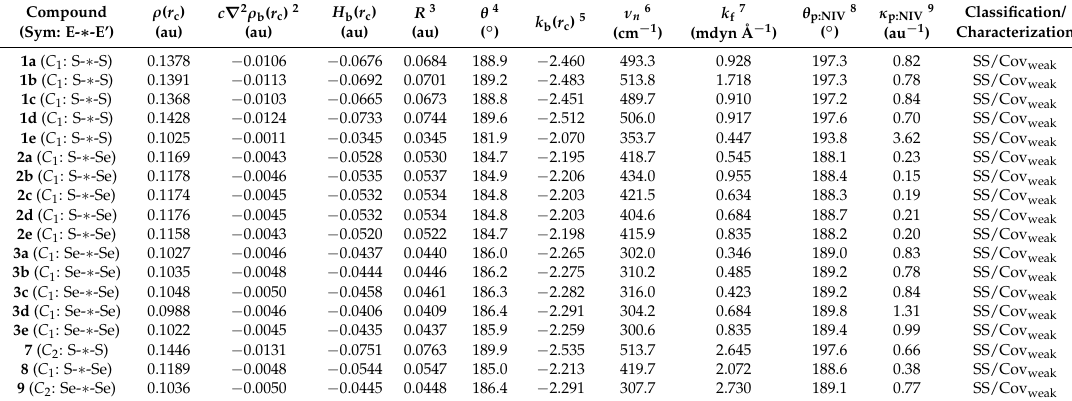
Table 2. QTAIM-DFA Parameters and QTAIM Functions at BCPs for the E- ∗ -E (cid:48) bonds in 1a – 3e and 7 – 9 , 1 together with the frequencies ( ν ) and force constants ( k f ) corresponding to the E- ∗ -E (cid:48) species in question.